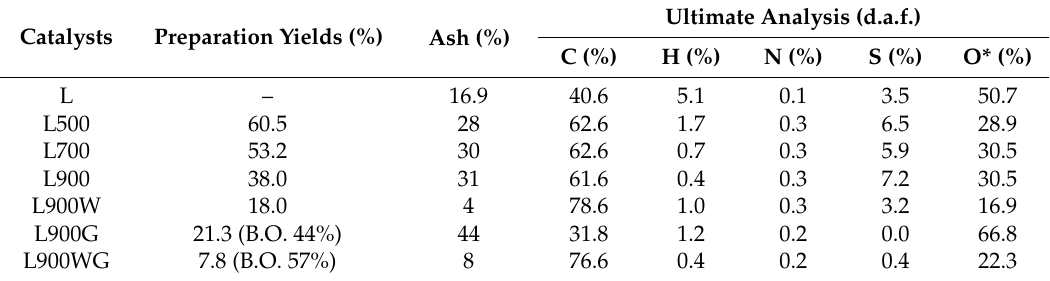
Table 1. Ash content, preparation yields, and ultimate analyses of the different samples.